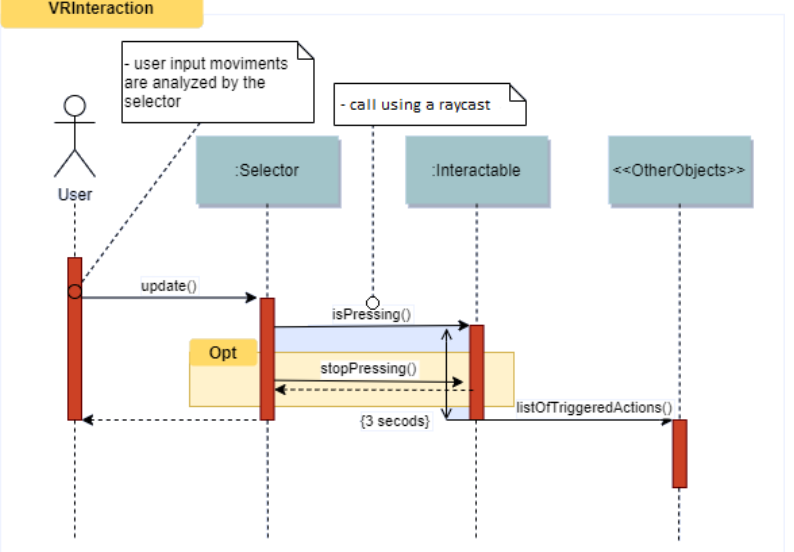
Figure 2. Sequence diagram indicating the calls performed by the interaction